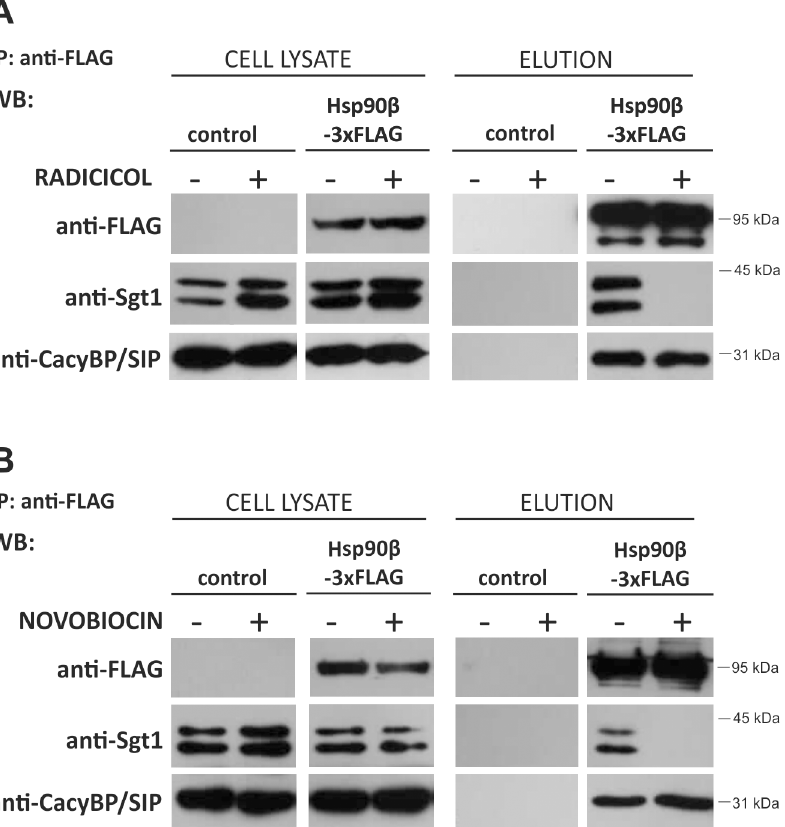
Fig 5. Influence of Hsp90 inhibition on Hsp90-CacyBP/SIP and Hsp90-Sgt1 complex formation. Co- immunoprecipitation of CacyBP/SIP and Sgt1 with FLAG-tagged Hsp90 β from HEp-2 cell lysate obtained after 2 hrs treatment with radicicol (A) or novobiocin (B) . Anti-FLAG staining shows expression of FLAG- tagged Hsp90 β . A representative Western blot, out of 3 performed, is